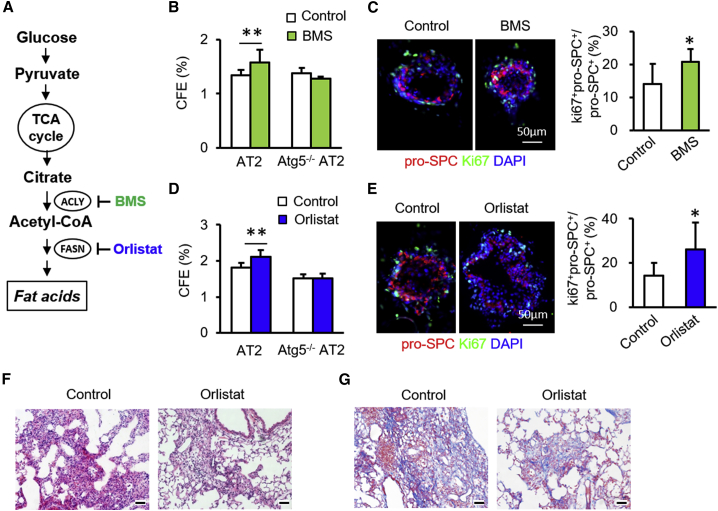
Fatty Acid Synthesis Pathway Negatively Influences AT2 Cell Proliferation(A) Schematic of intermediates and their inhibitors in fatty acid synthesis pathways.(B) CFE of mouse AT2 cultures with and without BMS (n = 5).(C) Immunostaining of organoid cultures and quantification of Ki67+pro-SPC+ cells in total pro-SPC+ cells in organoid cultures in the presence and absence of BMS (n = 5).(D) CFE of AT2 cell cultures with and without orlistat (n = 5).(E) Immunostaining of organoid cultures and proportions of Ki67+pro-SPC+ cells in total pro-SPC+ cells in organoid cultures in the presence and absence of orlistat (n = 5).(F and G) After intratracheal instillation of BLM, Nkx2.1Cre;Atg5f/f mice were intraperitoneally injected with PBS or orlistat. At 14 days after BLM, lungs were harvested for hematoxylin/eosin (F) and Masson trichrome (G) staining. Scale bar: 50 μm. Data are representative of two independent experiments with error bars representing the mean ± SD. ∗p < 0.05, ∗∗p < 0.01.